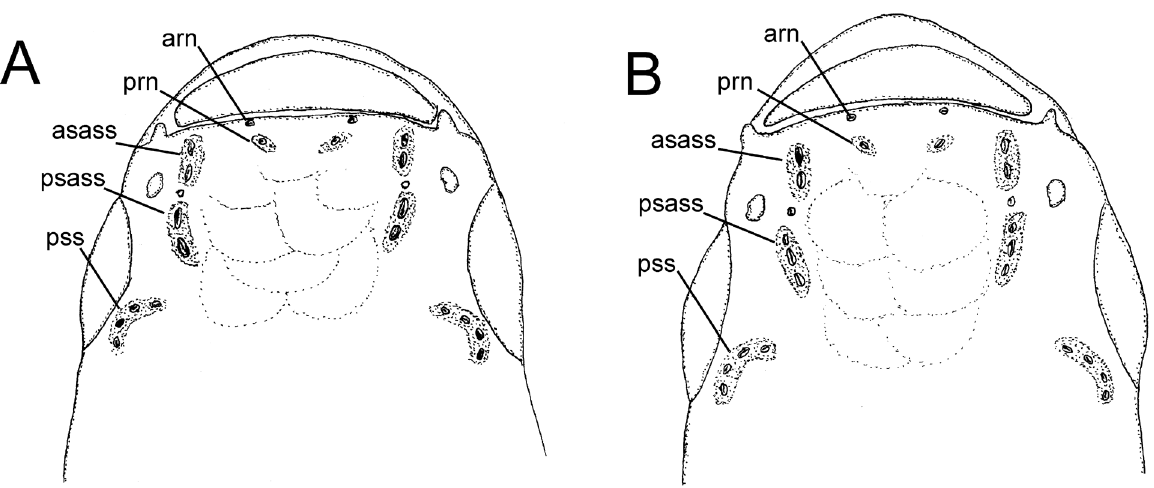
Figure 5. Diagrammatic representation of the latero-sensory system on the dorsal surface of the head in: A. Nothobranchius lucius , MRAC A7-02-P-28-32, male, 43.6 mm SL; B. Nothobranchius insularis sp. n., MRAC A702-P-38-44, paratype, male, 48.3 mm SL. arn – anterior rostral neuromast; asass – anterior section of the anterior supraorbital series; prn – posterior rostral neuromast; psass – posterior section of the anterior supraorbital series; pss – posterior supraorbital series.